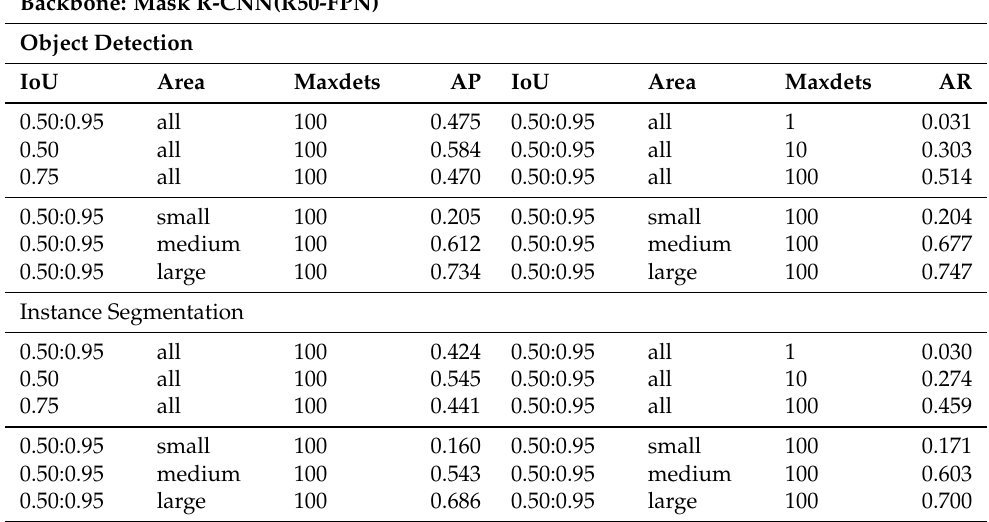
Table 4. COCO Evaluation Metrics for object detection and instance segmentation using Mask R-CNN (R50-FPN) baseline.